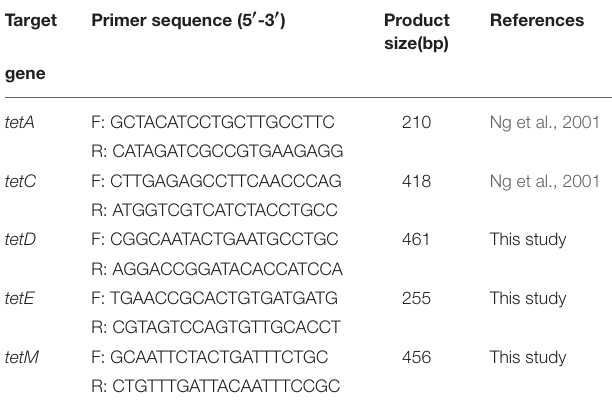
TABLE 1 | Primer sets for the detection of tetA, tetC, tetD, tetE, and tetM used in this study.